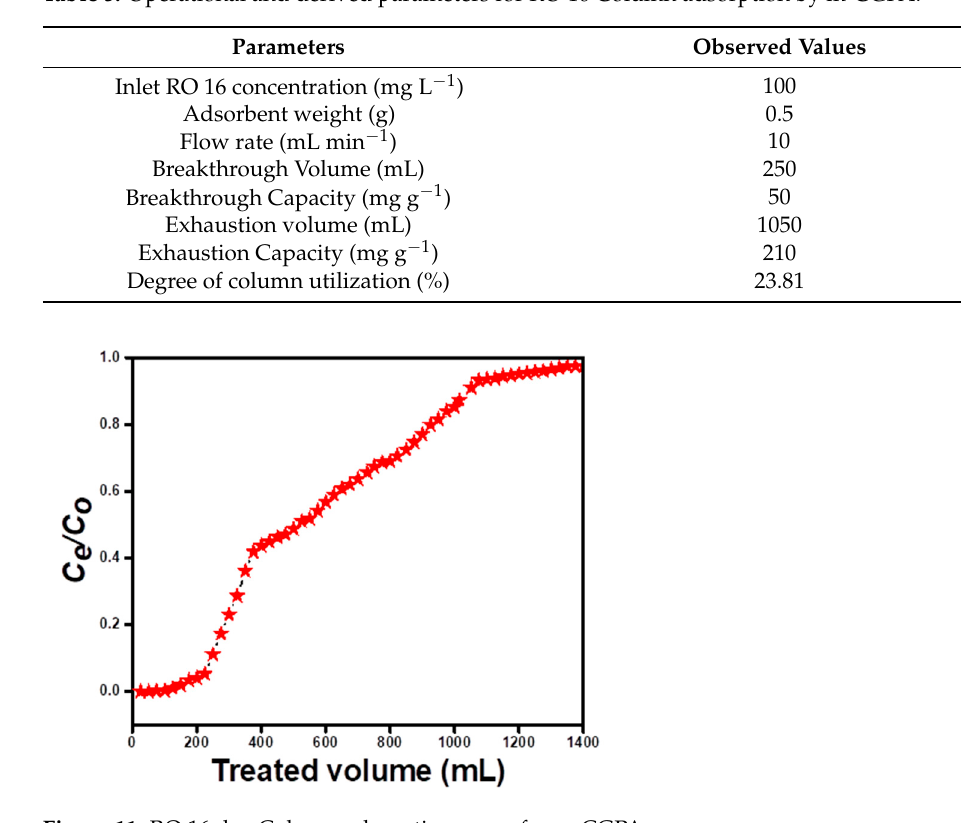
Table 5. Operational and derived parameters for RO 16 Column adsorption by m-CGPA.